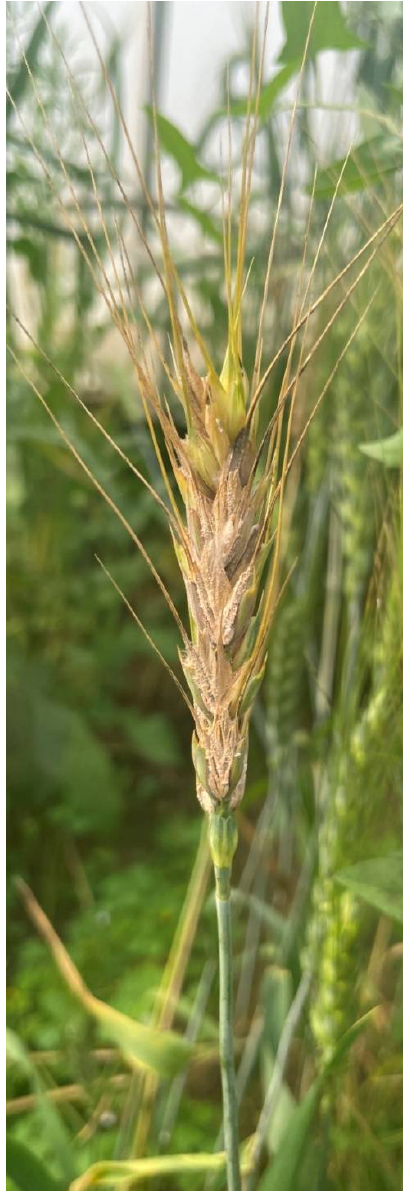
Figure 1. Typical symptoms of wheat head scab disease ( Fusarium graminareum ) on wheat spike.